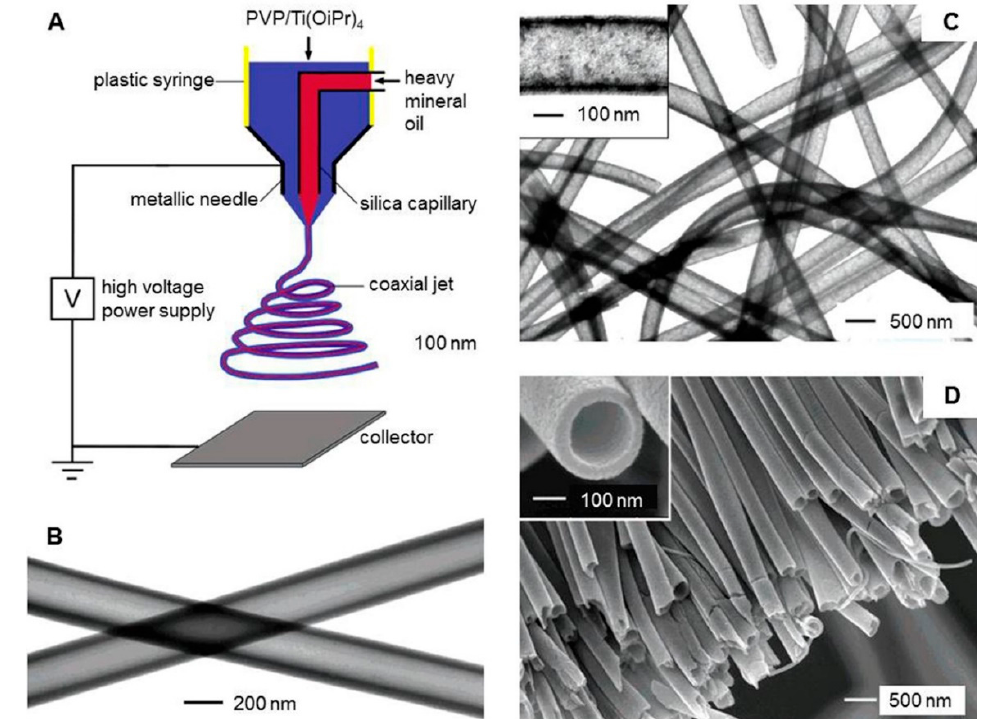
Figure 7. Preparation and characterization of electrospinning nanofibers with hollow structures. ( A ) Schematic illustration of the electrospinning setup for hollow structure nanofibers. ( B ) TEM image of the hollow fibers. The walls of these tubes were composed of amorphous TiO 2 and PVP. ( C ) TEM image of TiO 2 hollow nanofibers that were obtained by calcining the composite tubes in the air at 500 °C. ( D ) SEM image of TiO 2 hollow fibers that were in a uniaxially aligned array. Reproduced from [198] with permission from the American Chemical Society; Copyright 2004.